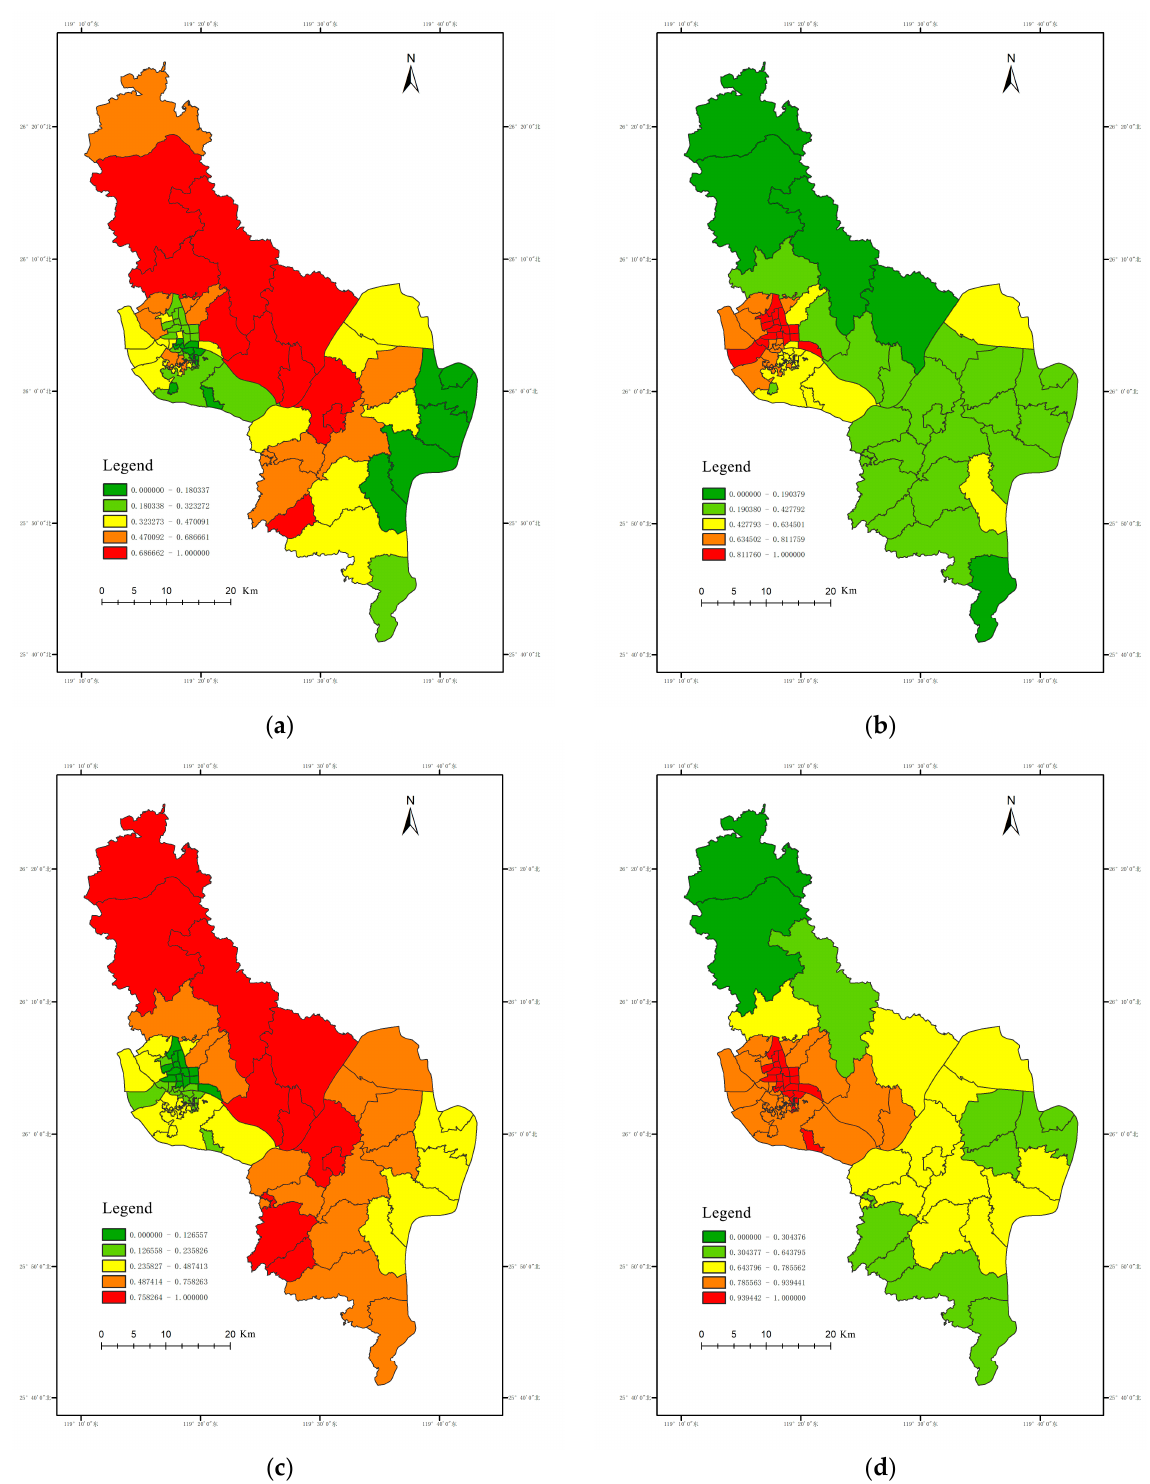
Figure 15. Spatial distribution of the single supply index of green space in urban areas of Fuzhou: ( a ) green space accessibility area index; ( b ) green space shape complexity index; ( c ) green space aggregation index; and ( d ) road integration index.